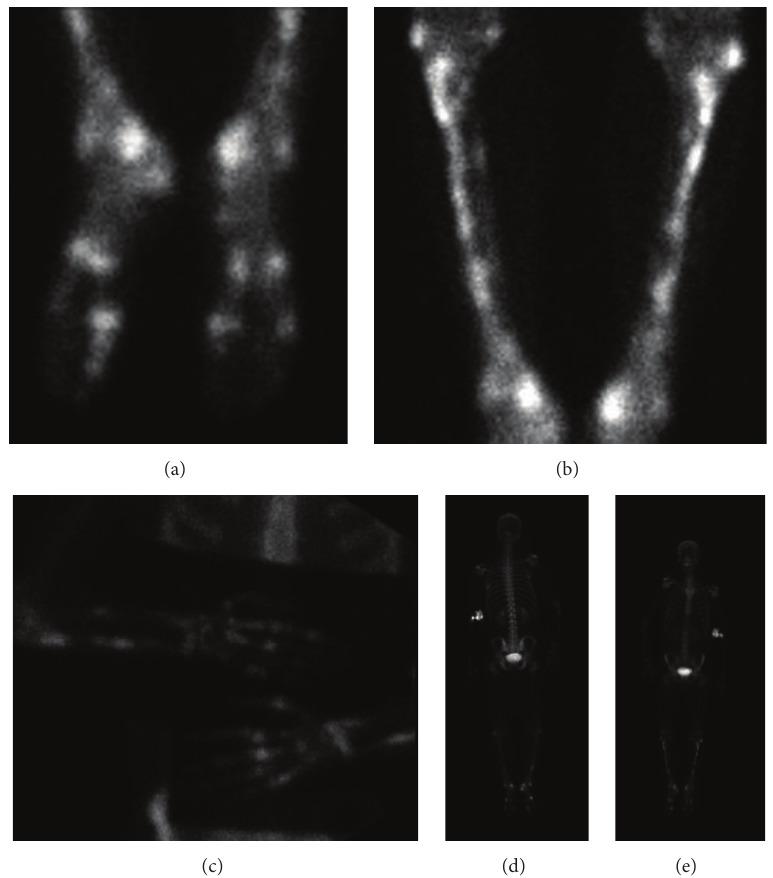
Figure 3: Nuclear medicine bone scan of the whole body showing extensive bilateral polyostotic patchy uptake within the distal appendicular skeleton, including the forearms, hands, tibias/fibulas, and feet. ((a) and (b)) Feet and tibiae, respectively. (c) Bilateral forearms and hands. ((d) and (e)) Whole body